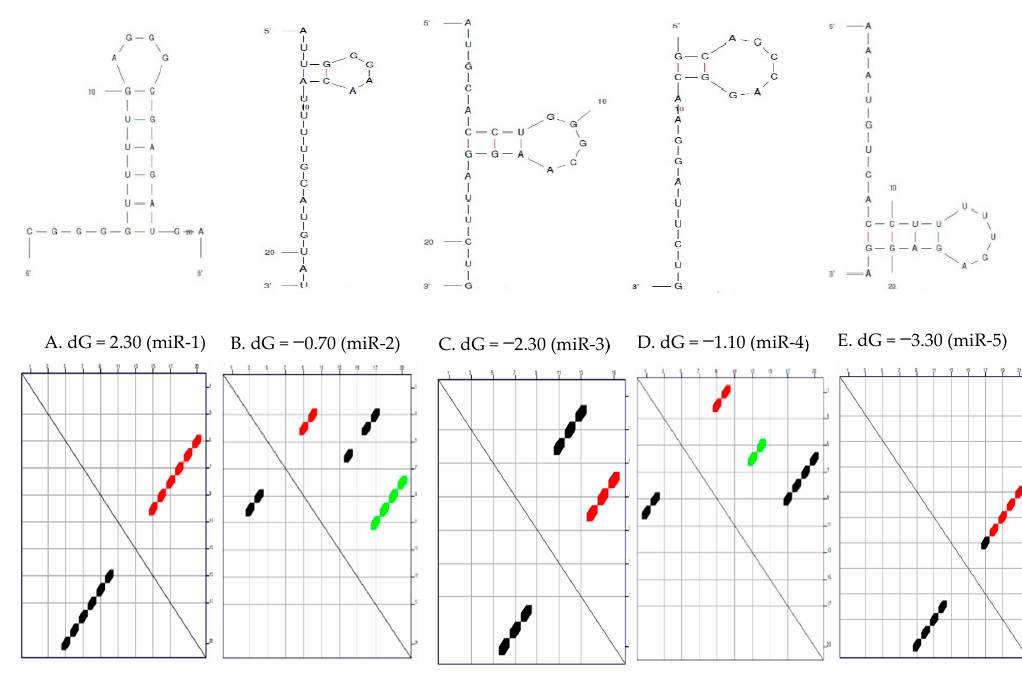
Figure 1. The predicted secondary structure of the five candidate microRNAs with their dot plot directly below showing the optimal energy. ( A ). microRNA miR-1 with its optimal energy of − 2.30; ( B ). MicroRNA miR-2 with its optimal energy of − 0.70; ( C ). microRNA miR-3 with its optimal energy of − 2.30; ( D ). microRNA miR-4 with its optimal energy of − 1.10; ( E ). microRNA miR-5 with its optimal energy of − 3.30. For the dot plots, red, black, and green dots represent all the optimal foldings (superposition of all possible sub-optimal foldings) Therefore, each colour represents a potential folding